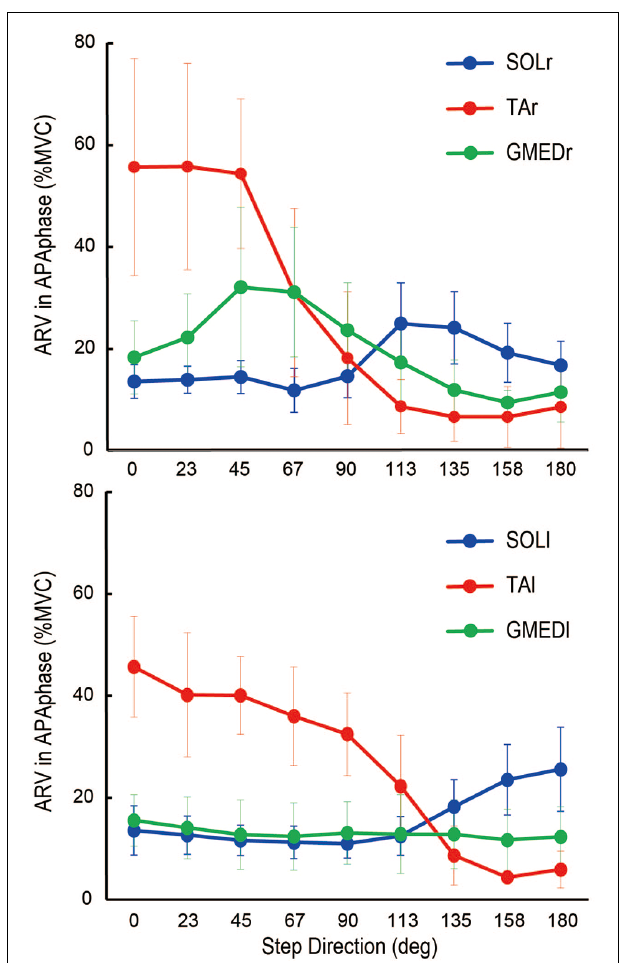
FIGURE 6 | Average rectified value (ARV) of electromyographic activity during APA phase of the soleus (SOL; blue), tibialis anterior (TA; red), and gluteus medius (GMED; green) of stance foot side (r) and stepping foot side (l) during multidirectional steps (mean ± standard deviation of all subjects). The values were normalized by ARV during maximal voluntary contraction (MVC) for each muscle. SOLr, TAr, and GMEDr are shown in the top figure, and SOLl, TAl, and GMEDl are shown in the bottom figure. The muscle activities were modulated according to the direction of steps ( P < 0.05).